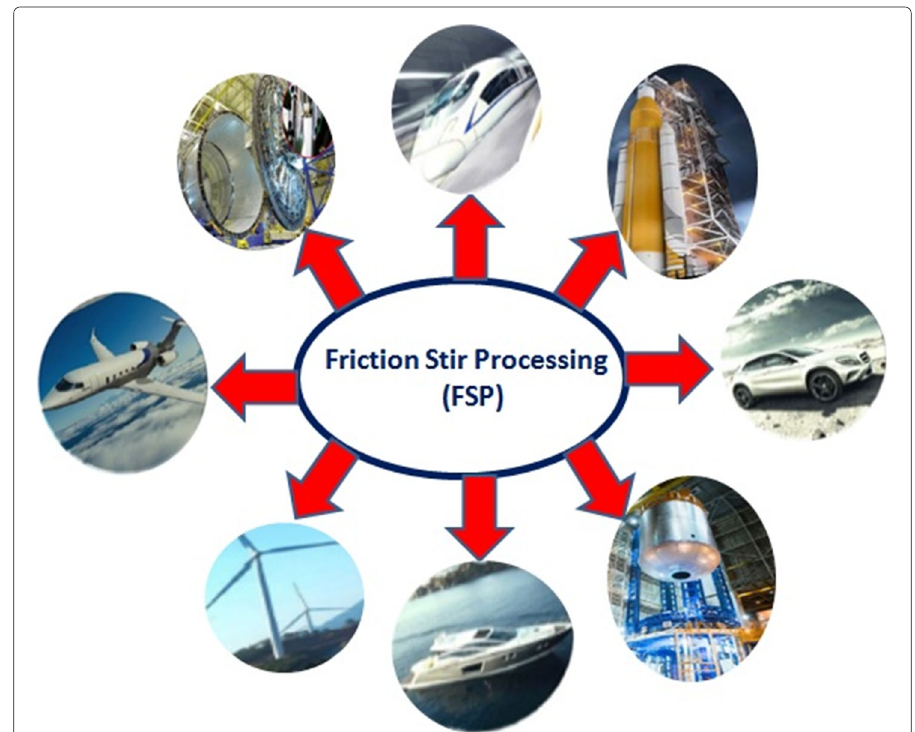
Fig. 1 Applications of FSP in Industry